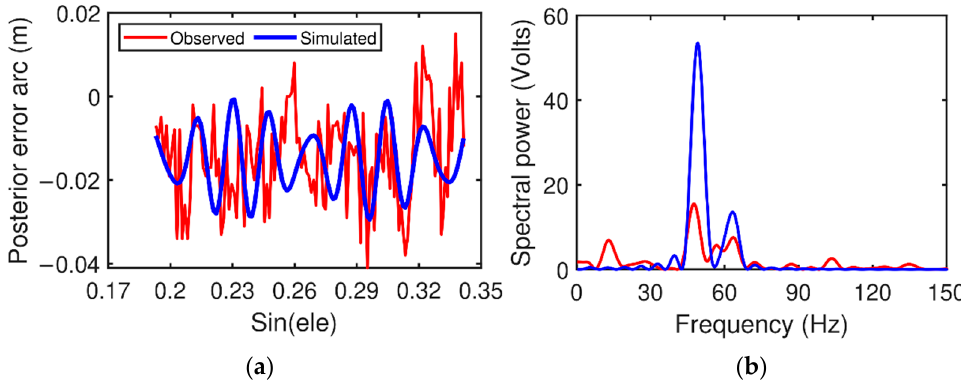
Figure 5. ( a ) PE arc of the DF carrier-phase combination (red) for GPS PRN01 received from site SC02 on DOY 1, 2022 and the simulated arc (blue); ( b ) the corresponding LSP results.